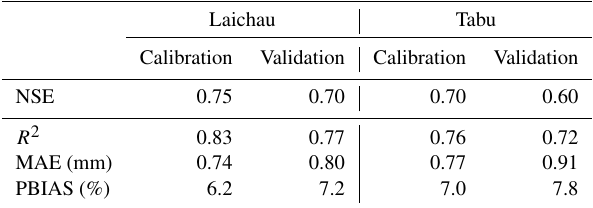
Figure 7. Comparison of observed and simulated daily stream- flow in the DRB (calibration period: 1991–1995, validation period: 1996–2000). Table 4. Evaluation of model simulation during the baseline period for the catchments controlled by Laichau and Tabu stations in the